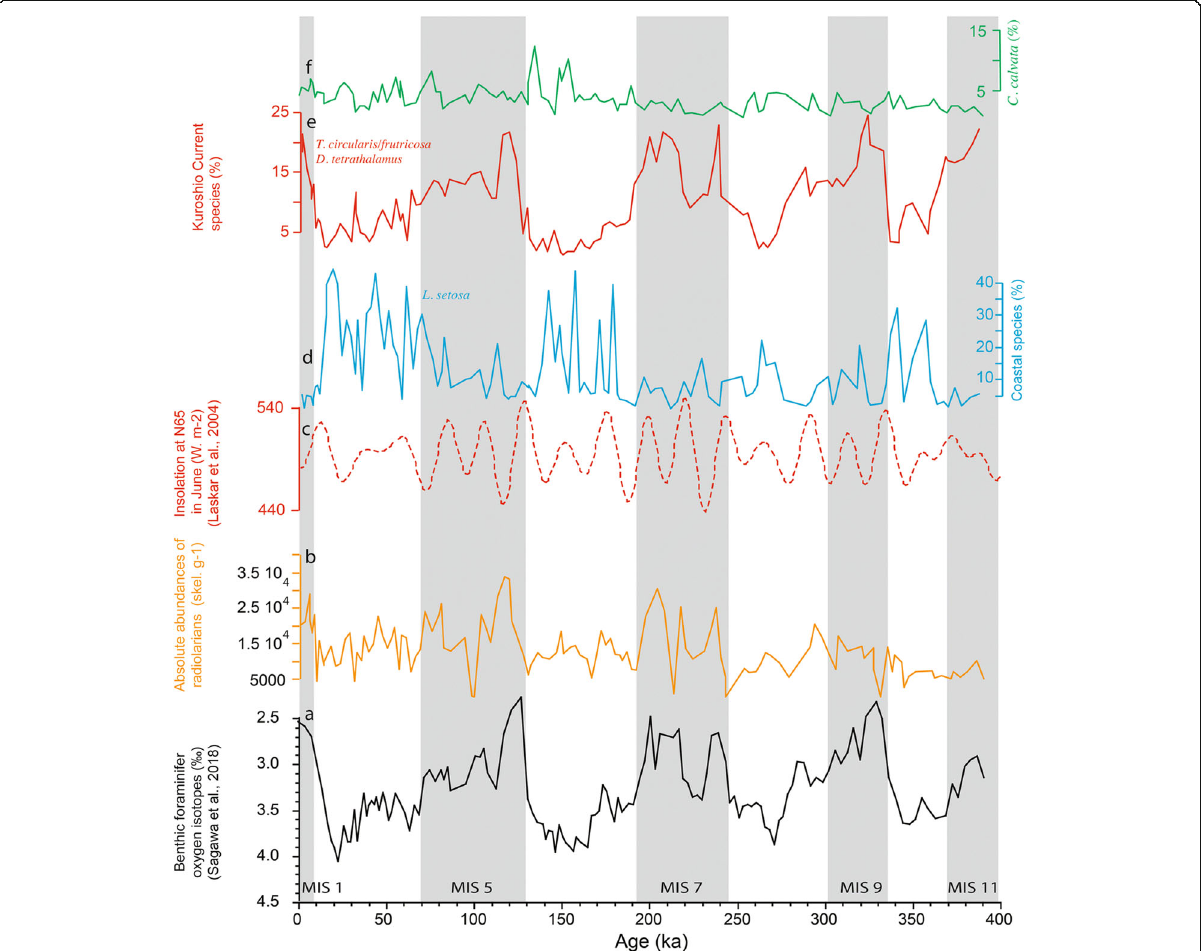
Fig. 7 Temporal fluctuation of various radiolarian abundances: a benthic foraminifera isotope curve of Sagawa et al. (2018), b radiolarian absolute abundance, c insolation at 65° N (Paillard et al. 1996), d coastal water species (%), e KC-related species (%), and f continental shelf species